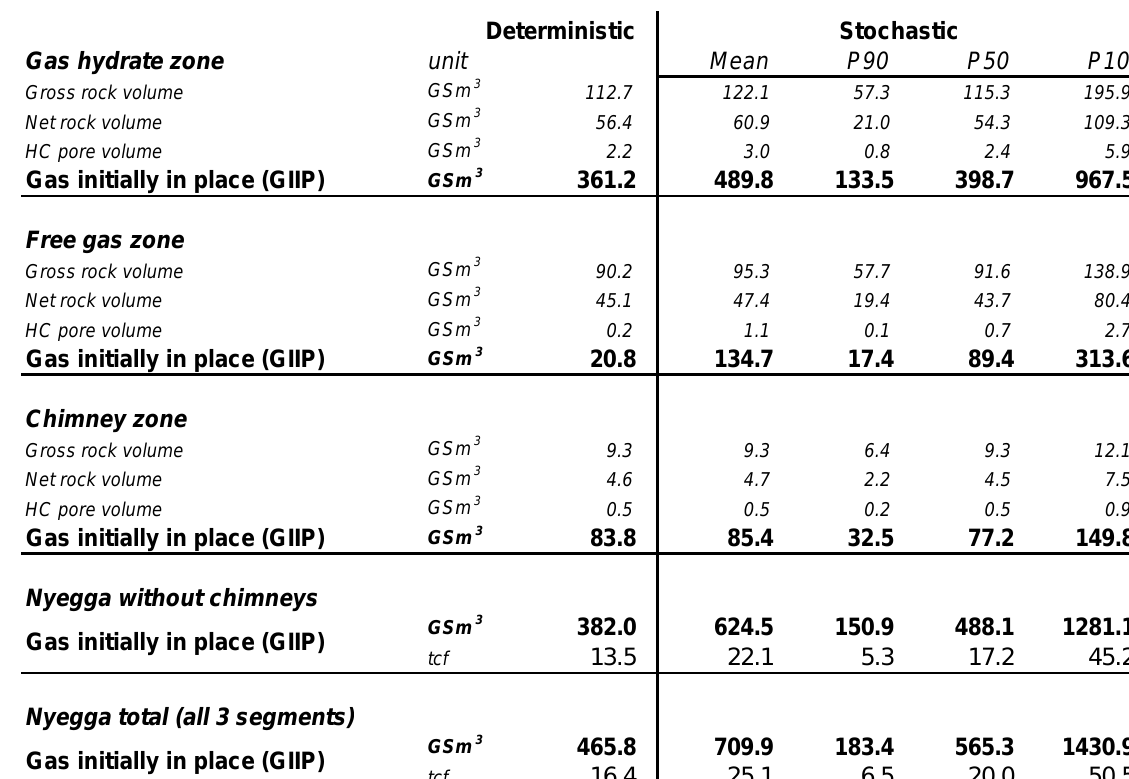
Table 3. Results of in-place volumes of hydrate-bound methane at Nyegga. Intermediate volumes are given for comparison. To calculate the deterministic volume, only the base case reservoir parameters were used. In contrast, wide distributions were used to generate the stochastic